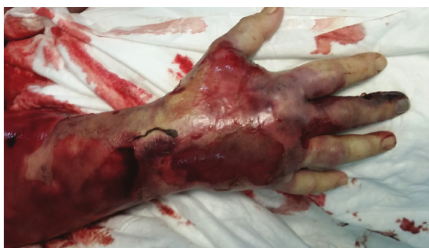
Figure 1: Tissue injury with appearance of erythroderma bullosa.